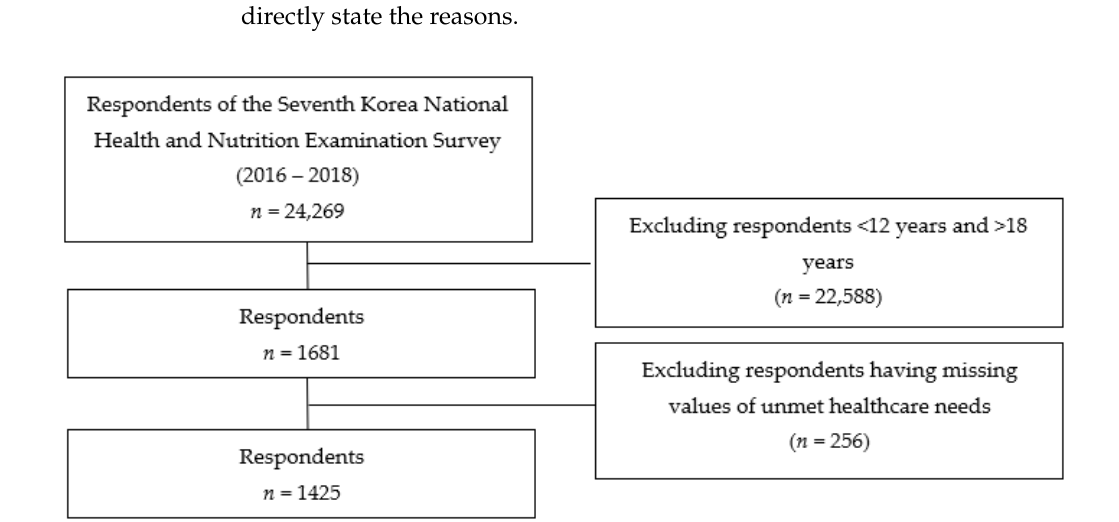
Figure 1. The process of selecting respondents.